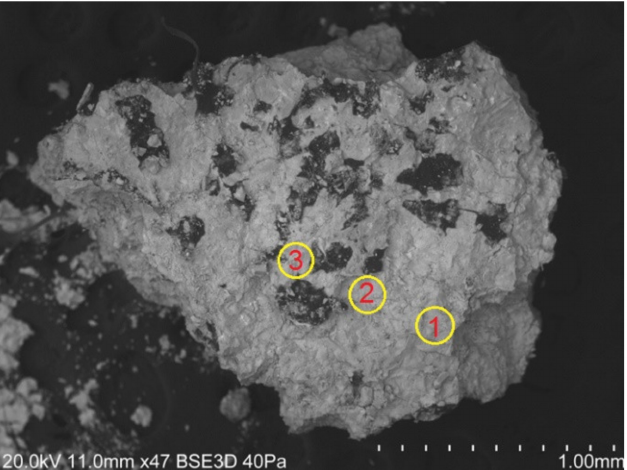
Figure 5. Selected areas on the back of the ornament piece: 1, 2 and 3.